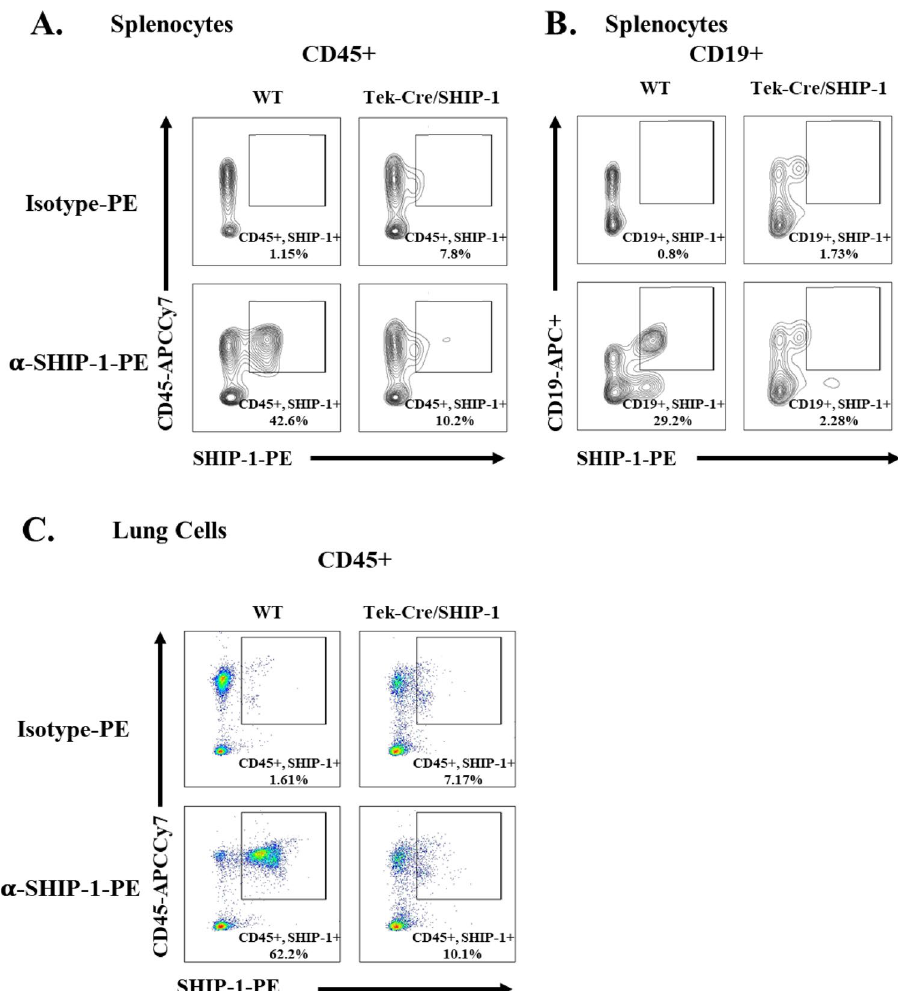
Figure 1. Flow cytometry analysis of SHIP-1 expression in tissue cells. Cells were prepared from spleen and lung tissues of WT and Tek-Cre/SHIP-1 mice 3–8 weeks of age and stained with labeled antibodies to cell markers (CD45 and CD19) and intracellular SHIP-1 and analyzed by flow cytometry. ( A ) Splenocytes from WT and Tek-Cre/SHIP-1 mice stained with anti-CD45 and anti-SHIP-1 antibodies; ( B ) CD45 + gated splenocytes stained with anti-CD19 and anti-SHIP-1; ( C ) Lung tissue cells from WT and Tek-Cre/SHIP-1 mice stained with anti-CD45 and anti-SHIP-1 . Shown are representative results of 3 separate experiments. Numbers are percentages of